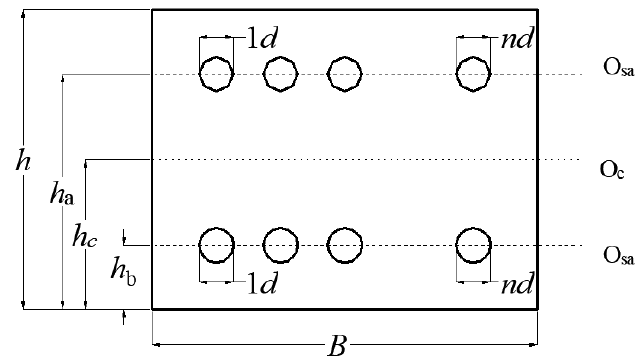
Figure 3. Geometry of the neutral axis of the combined section.